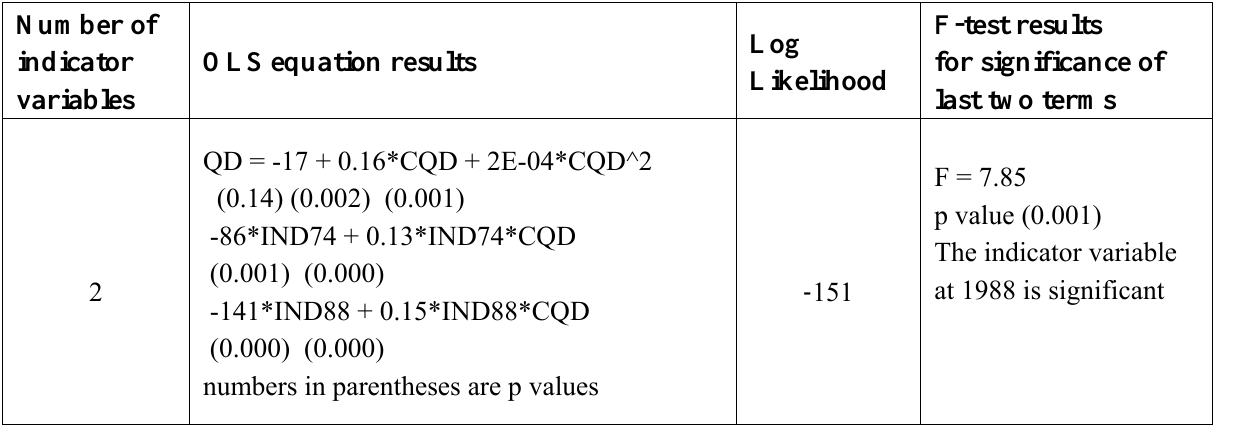
Table 3. Triple Hubbert Cycle OLS